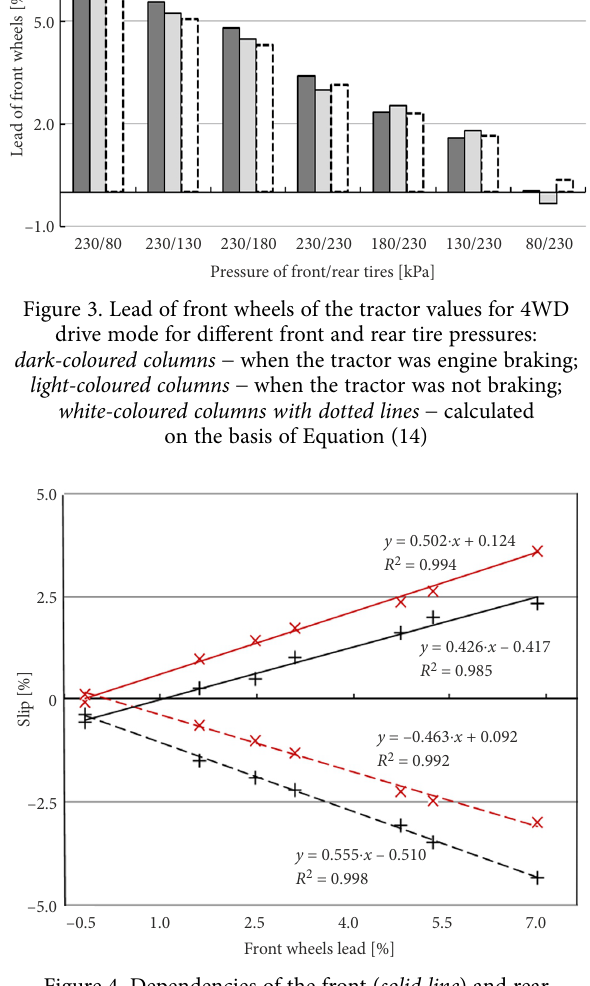
Figure 4. Dependencies of the front ( solid line ) and rear ( dashed line ) wheels slip/skid on the lead of front wheels for the tractor travelling in 4WD mode: “+” – when the tractor was engine braked; “ × ” – when the tractor was not braking